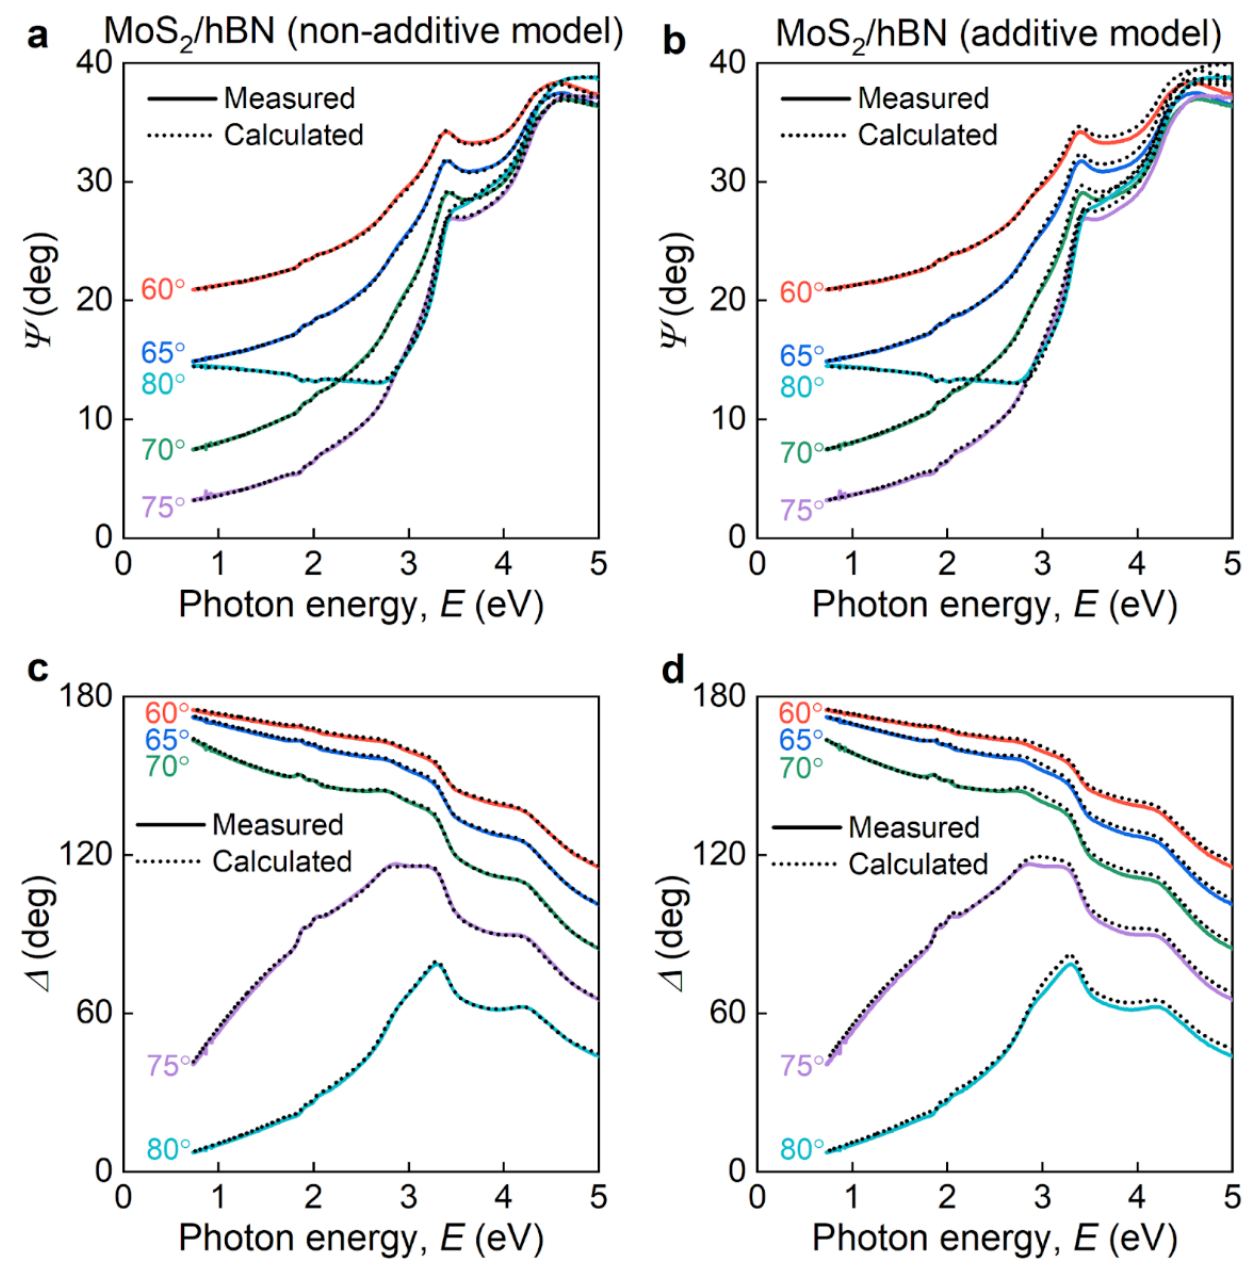
Figure A2. Ellipsometry spectra of MoS 2 /hBN heterostructures. Comparison of non-additive and additive optical models for ( a , b ) Ψ and ( c , d ) ∆ . Red, blue, green, violet, and cyan lines correspond to 60 ◦ , 65 ◦ , 70 ◦ , 75 ◦ , and 80 ◦ incident angles, respectively.